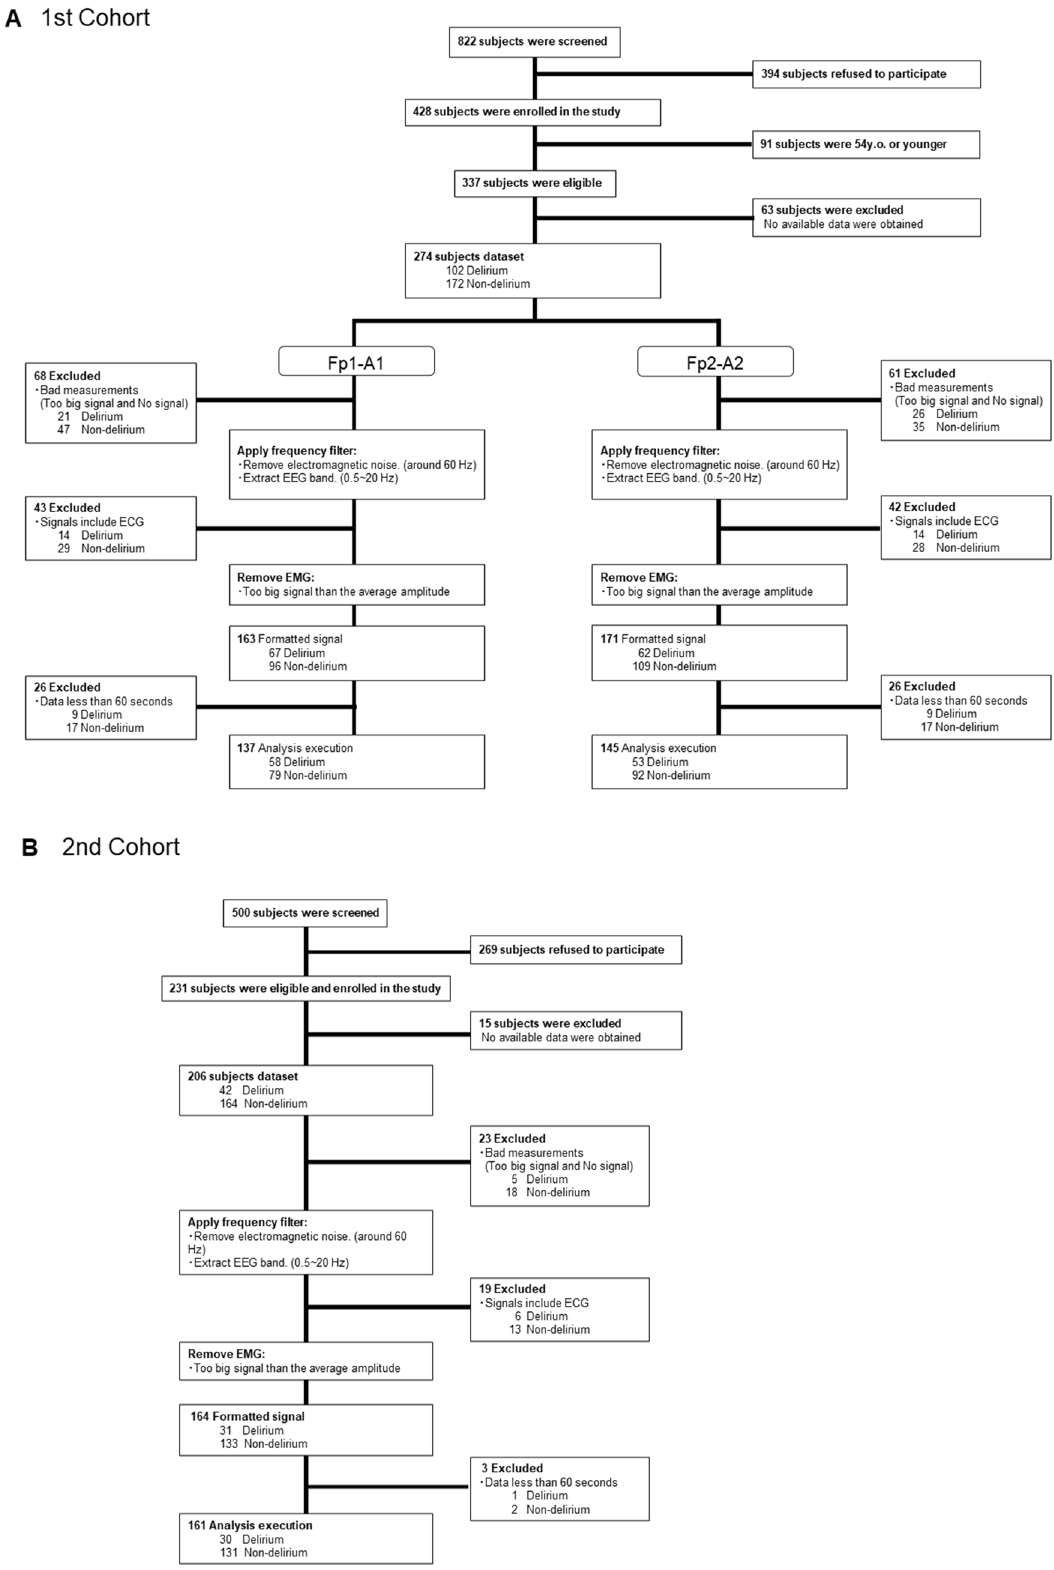
Figure 1. Flow of participants through the study. ( A ) cohort 1, ( B ) cohort